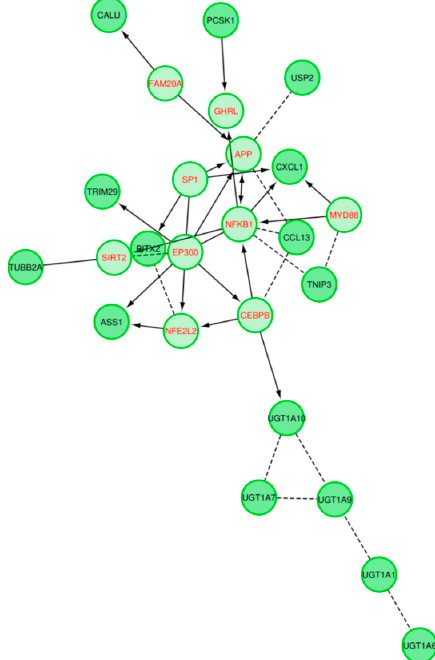
Figure 11. Reactome Functional Interaction visualization of the IBD dataset. Dashed edges are predicted associations. Directional edges indicate regulation, and T junction edges represent inhibition.